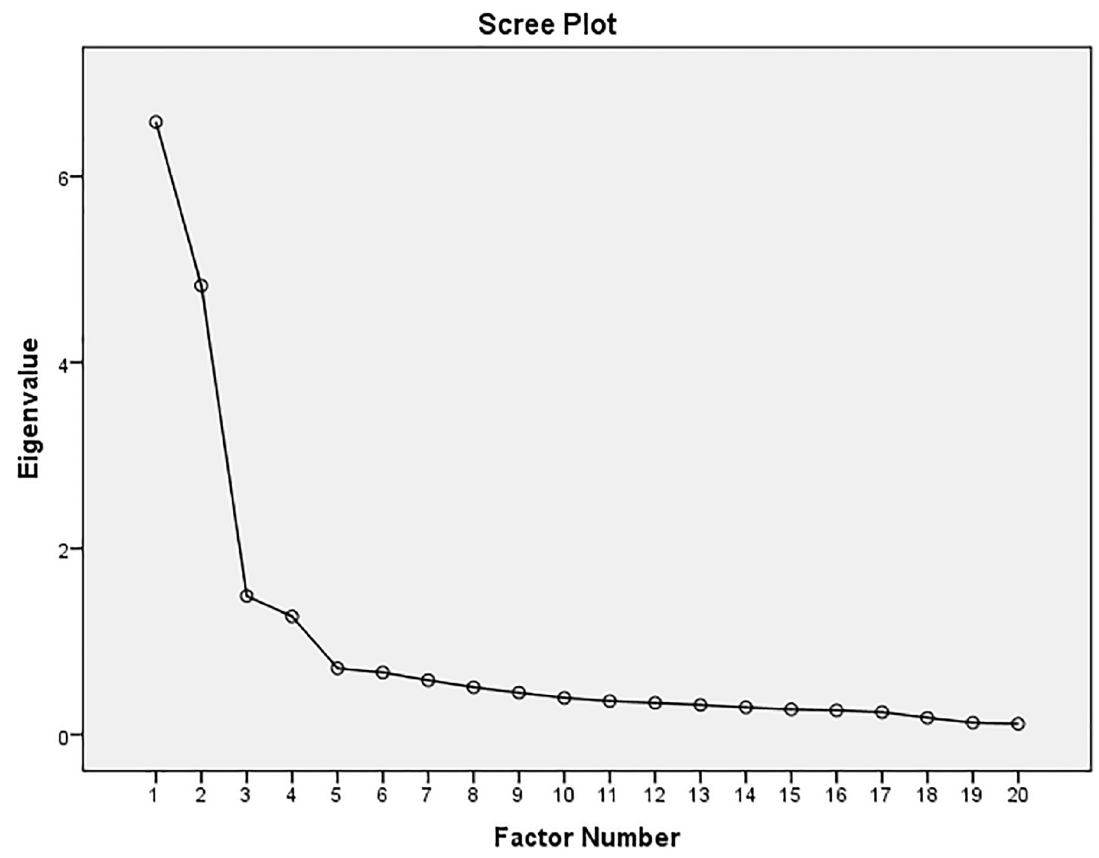
Fig 1. Scree Plot depiction based on the